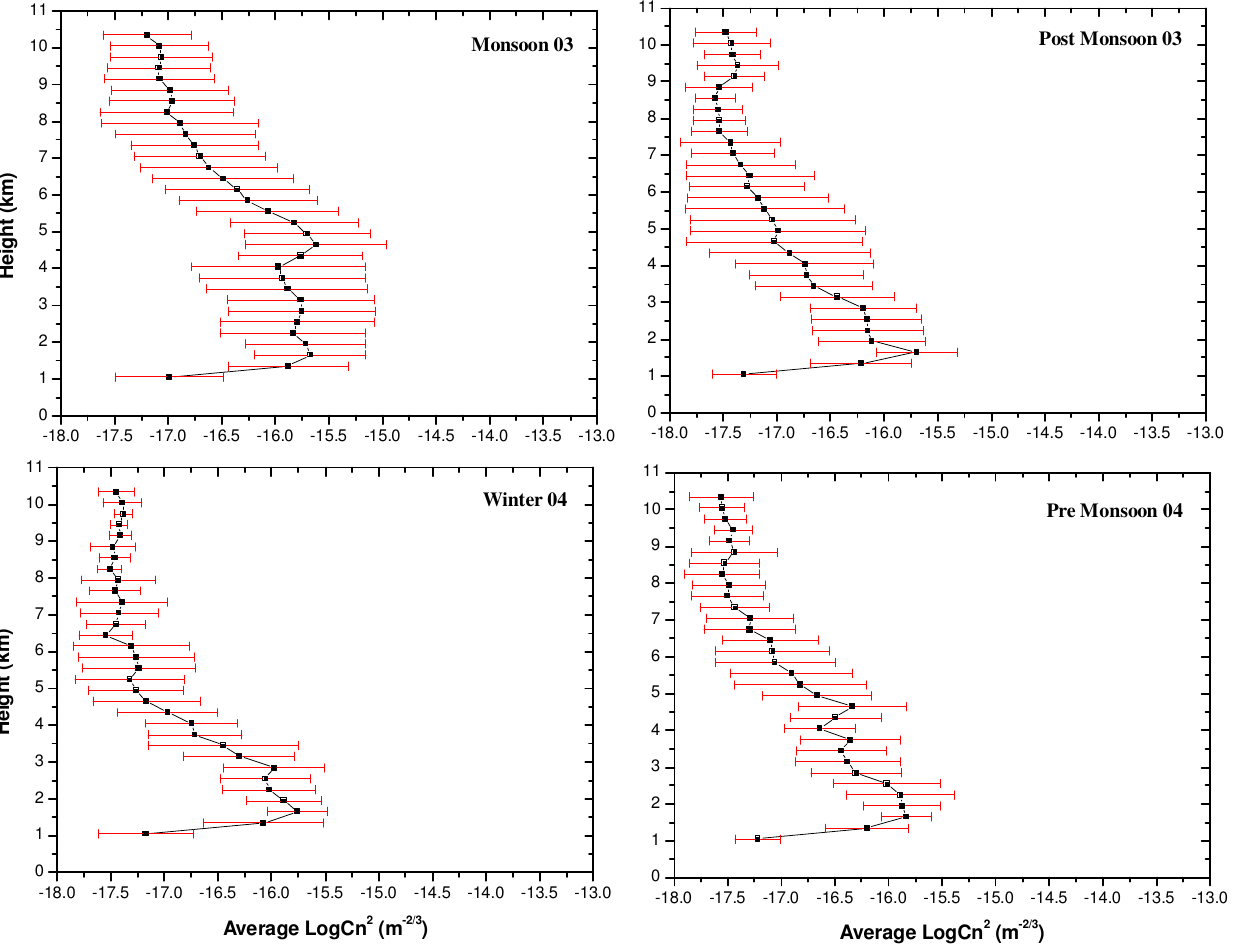
Fig. 2. Seasonal features of C 2 n with standard deviation, year 2003–2004. Total number of available data points for calculating seasonal mean and standard deviation are 71 (for monsoon 2003, the upper left panel), 76 (for post-monsoon 2003, upper right panel), 54 (for winter 2004, bottom left panel), and 62 (for pre-monsoon 2004, bottom right